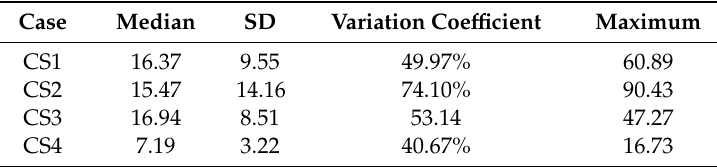
Table 10. The daily PM 2.5 means ( µ g / m 3 ) during